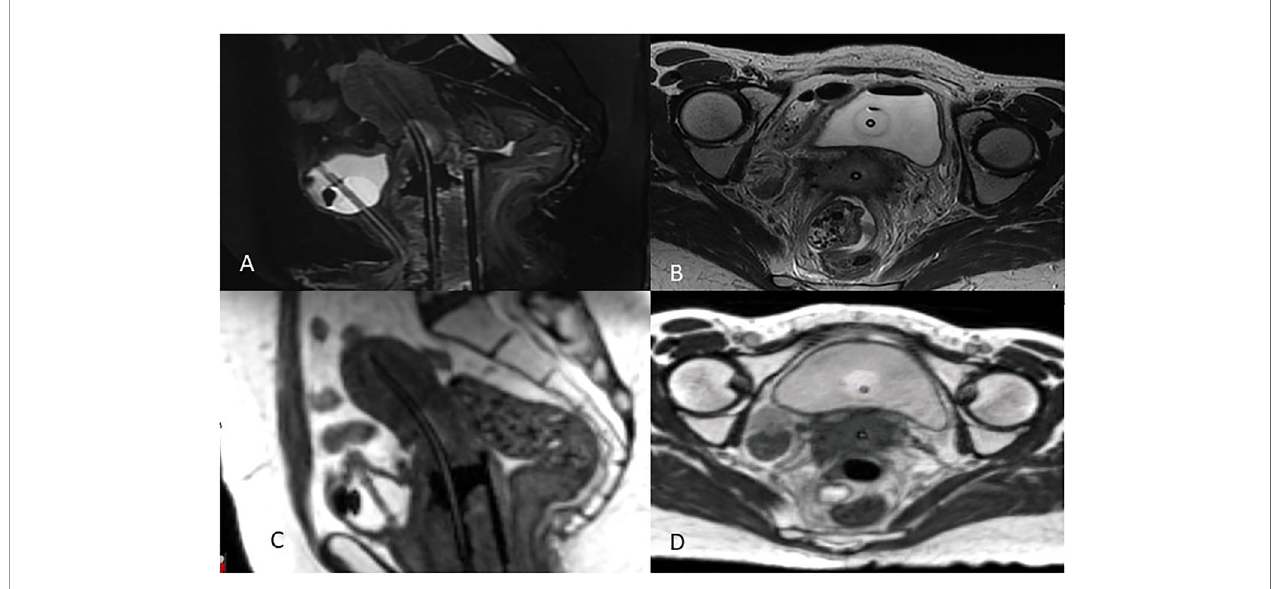
FIGURE 2 | MRg Brachytherapy 3T Diagnostic MRI (A) Sagittal and (B) axial views compared to 0.35T MRIdian MRI (C) Sagittal (D) axial